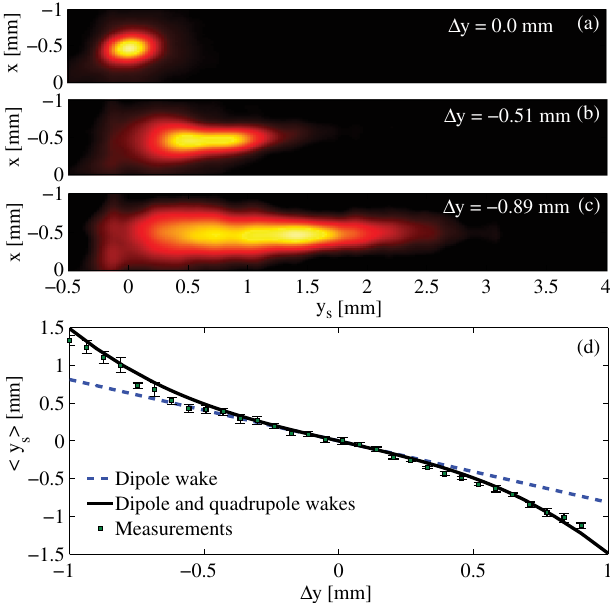
FIG. 3. (a – c) Measured transverse beam images at YAG:Ce screen for different offsets of the passive streaker . The head of the bunch is on the right and the tail on the left. (d) Measured average vertical beam centroid as a function of the vertical offset of the passive streaker against model expectations based on the dipole wake function (dashed) and the dipole and quadrupole wake functions